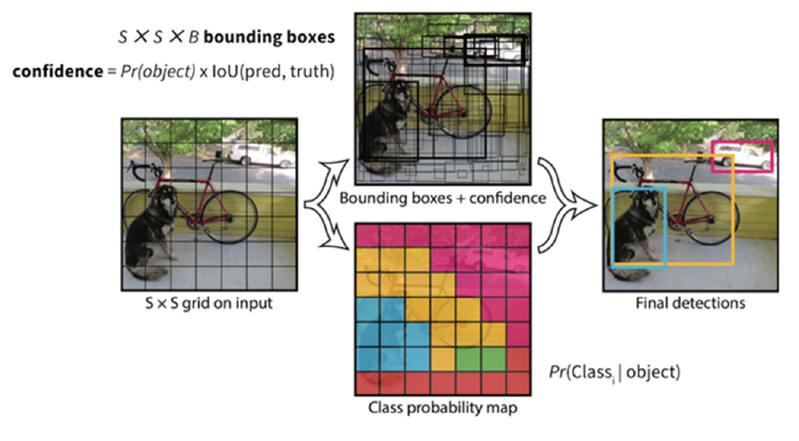
Figure 6. YOLO workflow [23].